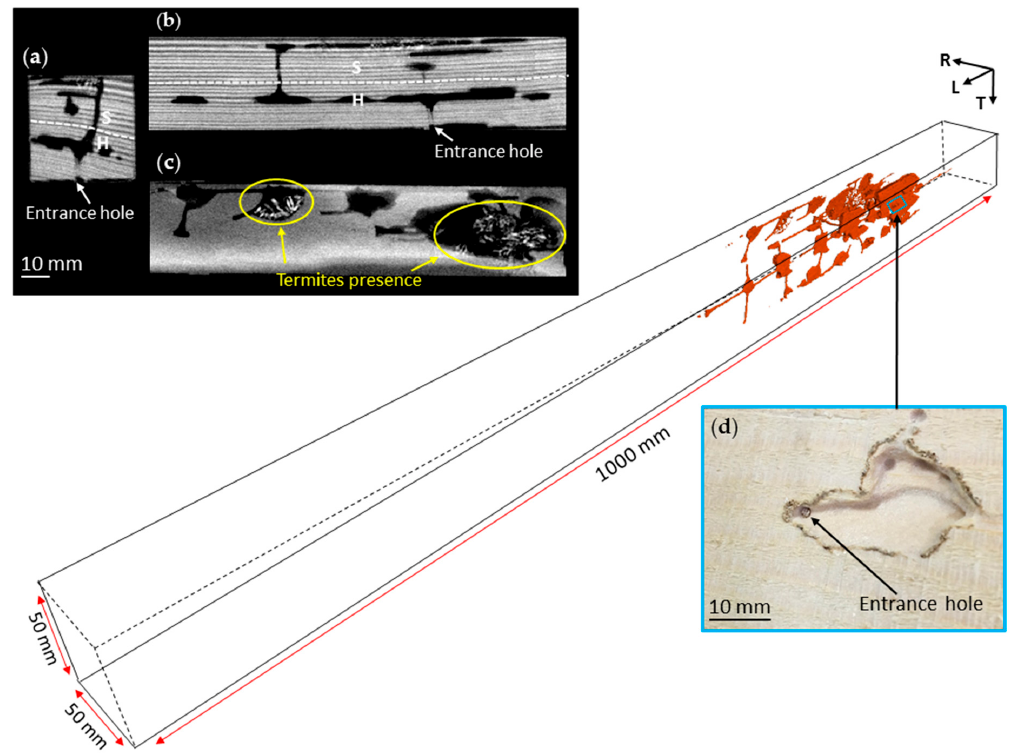
Figure 4. CT images of nest-gallery system in Spruce B timber. ( a ) A 2D cross-sectional image; ( b ) a 2D radial image, indicated that the nest-gallery has been extensively excavated throughout the sapwood (S) and heartwood (H); ( c ) a 2D tangential image, taken from the sapwood part on the opposite surface of the entrance hole; and ( d ) a close-up view of the entrance hole. Termite presence is indicated by an uncolored area inside the nest-gallery in the 3D image or a yellow circular shape in the 2D tangential image. In 2D CT images, the gray value of a pixel corresponds to an index of density: the lighter the color, the denser the area. Springwood and summerwood are indicated by the darker and lighter colors in the images, respectively. The arrow axis represents the longitudinal (L), radial (R), and tangential (T) section of the timber. S, sapwood, H, heartwood.